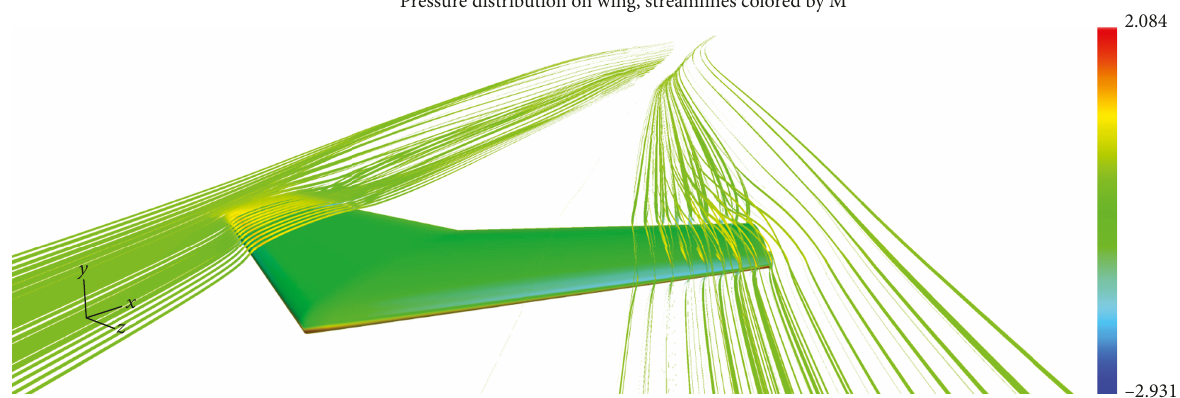
Figure 14: Plain BGK wing under side wind shear (SW2).